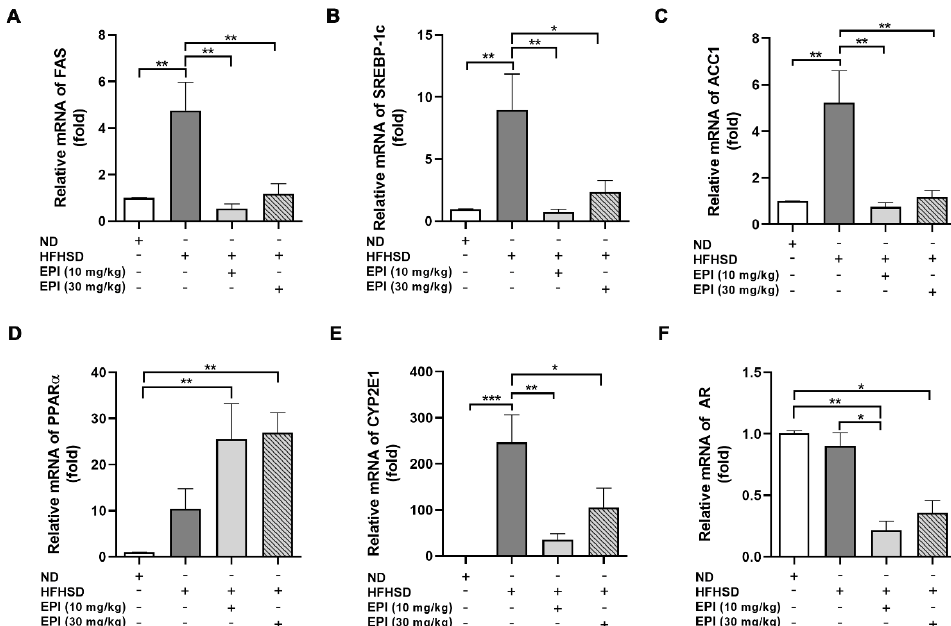
Figure 5. Quantification of lipid synthesis-related gene expression by RT-qPCR assay in mouse liver. EPI (EPI-001) inhibited the expression of ( A ) FAS (fatty acid synthase), ( B ) SREBP-1c (sterol regula- tory element-binding protein-1c), and ( C ) ACC1 (acetyl-CoA carboxylase 1); ( D ) EPI enhanced the expression of PPAR α (peroxisome proliferator-activated receptor- α ); ( E ) EPI inhibited the expression of CYP2E1 (Cytochrome P450 2E1); ( F ) The effect of EPI on the expression of AR (androgen receptor). (mean ± SEM, * p < 0.05, ** p < 0.01, *** p < 0.001, n = 6 mice per group).